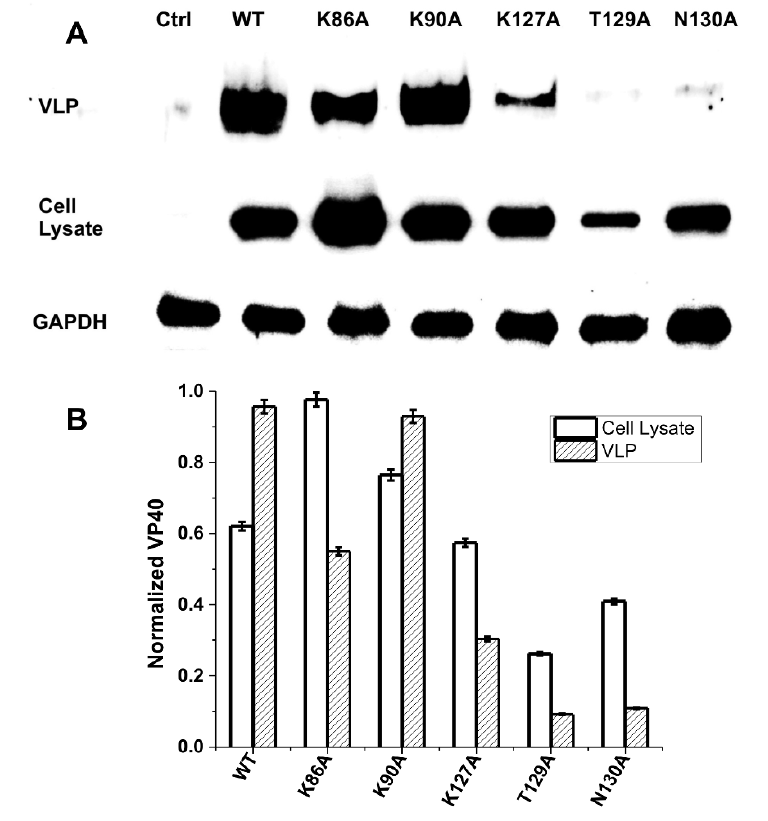
Figure 8. VLP analysis of VP40 and respective mutations. CHOK-1 cells were transfected with plasmid DNA encoding either empty EGFP plasmid (control) or WT VP40, K86A, K90A, K127A, T129A, or N130A EGFP fusion constructs. ( A ) The cell lysate and